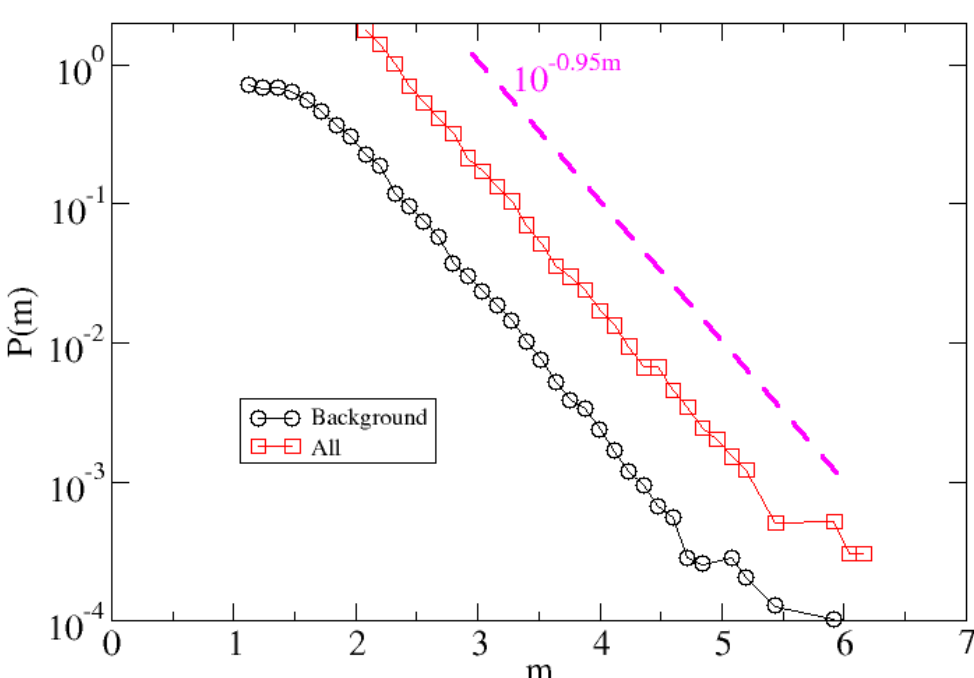
Figure 2. Instrumental magnitude distribution P ( m ) for the Italian seismicity. Black circles represents only the background activity whereas red squares the whole